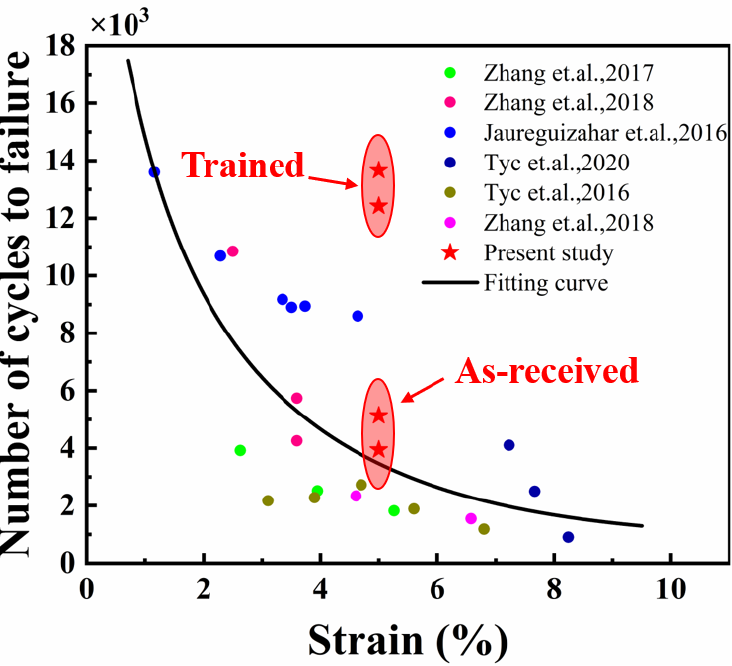
Figure 5. Comparison of structural fatigue life for NiTi SMA wires reported in previous research and this work [5,6,28–31].